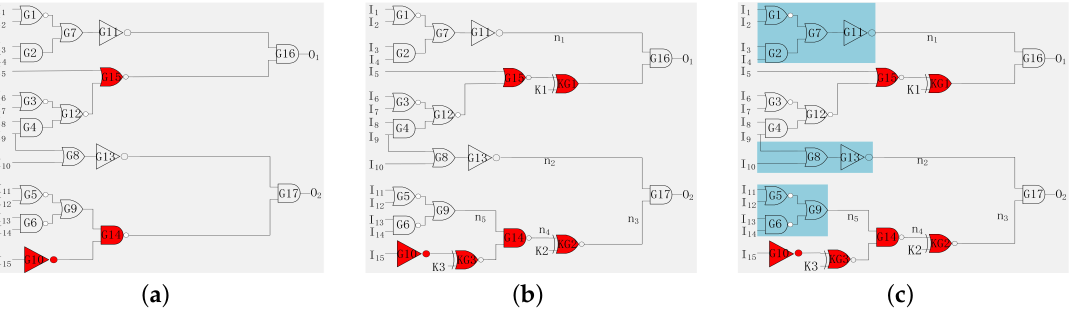
Figure 3. Security threats against path sensitization attack. ( a ) An example circuit. ( b ) Circuit encrypted with three key-gates. ( c ) Path sensitization